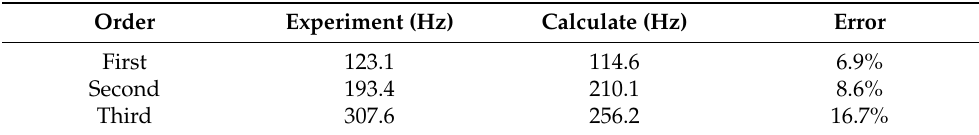
Table 1. Natural frequencies comparisons between experiments and FEM analyses.